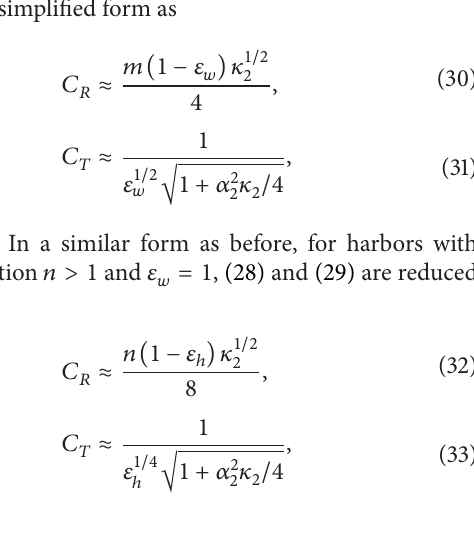
linear or parabolic transitions among other transitions or a combination of these